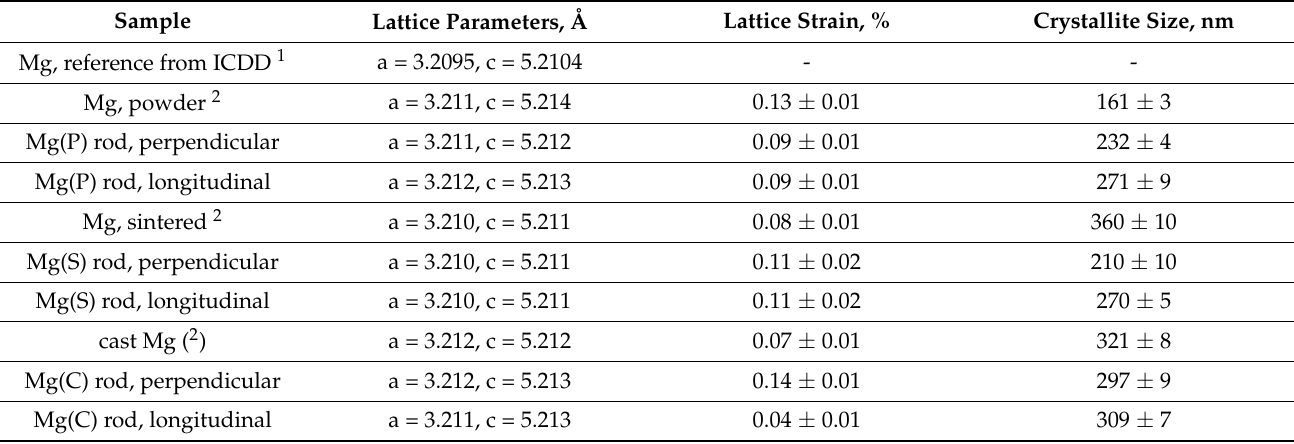
Table 3. Lattice parameters, lattice strain, and crystallite size determined for raw materials and rods extruded by KOBO